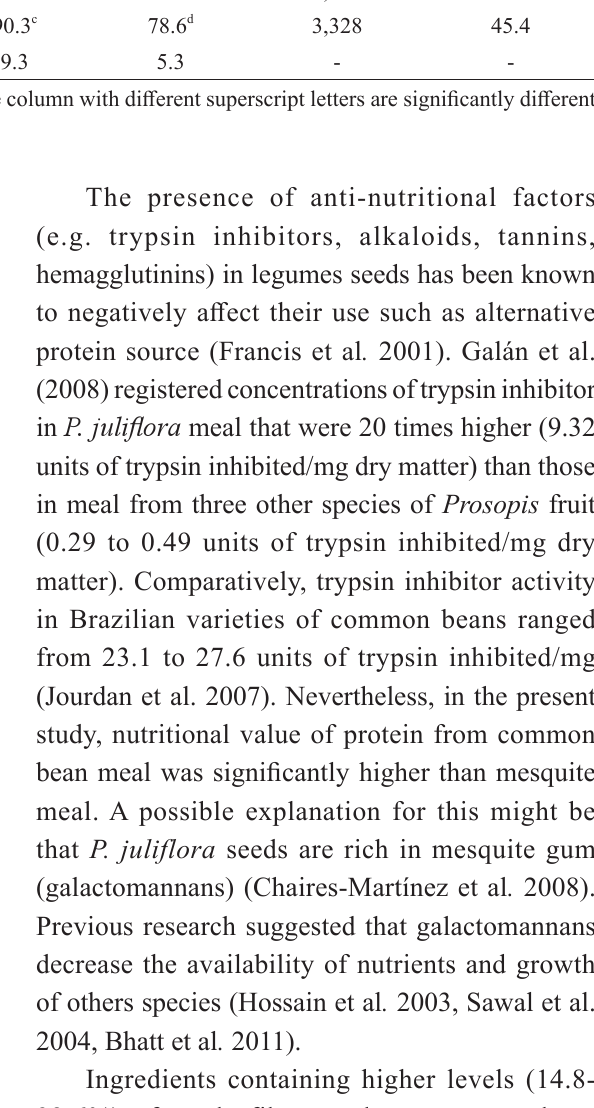
Values are means of three replicates, and values within the same column with different superscript letters are significantly different (p≤0.05). 1 Dry matter